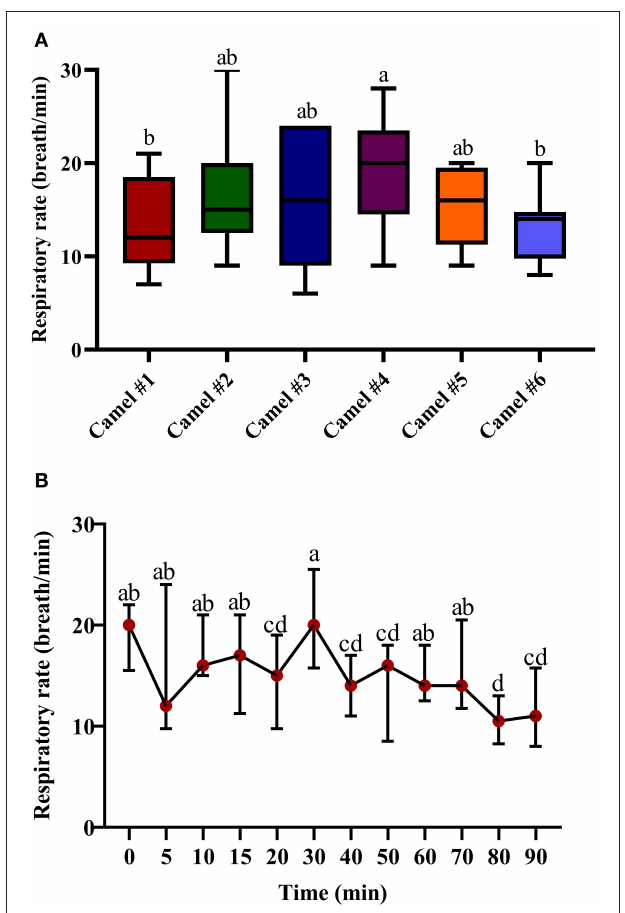
FIGURE 5 | The changes in body temperature ( ◦ C) in camels after injection of acepromazine (0.1 mg/kg i.v.). (A) Boxplot showing body temperatures ( ◦ C) with all data points represented. (B) The median body temperatures ( ◦ C) 90min after acepromazine injection. Median values in each plot followed by a different lowercase letter (a, b, c) are significantly different by the Duncan test at p ≤